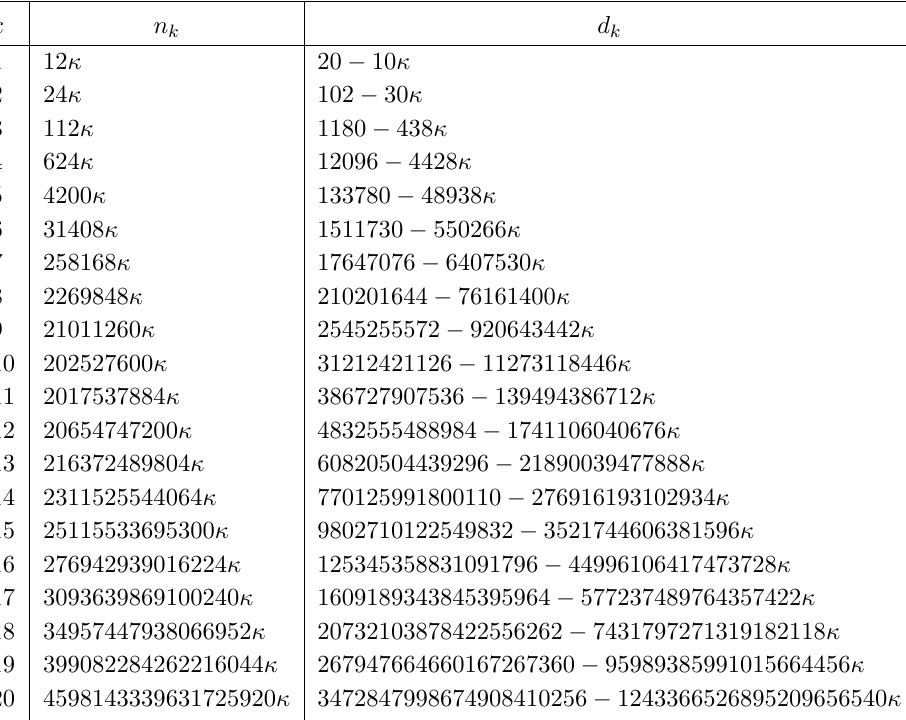
Table 11 . The (cid:12)rst few instanton numbers, n k , for genus zero, and d k , for genus